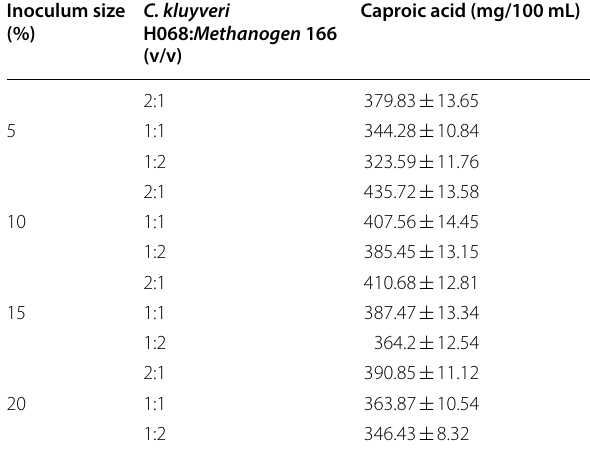
Table 1 Effect of different inoculum sizes and ratios of C. kluyveri H068 and Methanogen 166 on the production of caproic acid after 10 days of co-culture fermentation Inoculum size